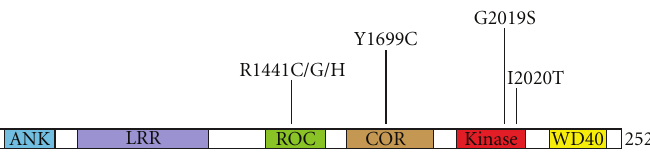
Figure 1: Domain structure and PD mutations of LRRK2. The central region of LRRK2 contains a GTPase domain also called (ROC), a C-terminal of ROC (COR) domain of unknown function, and a kinase domain, flanked on either side by protein-protein interaction domains including an ankyrin repeat domain (ANK), leucine-rich repeats (LRR) and a WD40 domain (WD40). Clearly causative pathogenic mutations are indicated and are clustered around the catalytic domains of LRRK2. Only the G2019S mutation consistently augments kinase